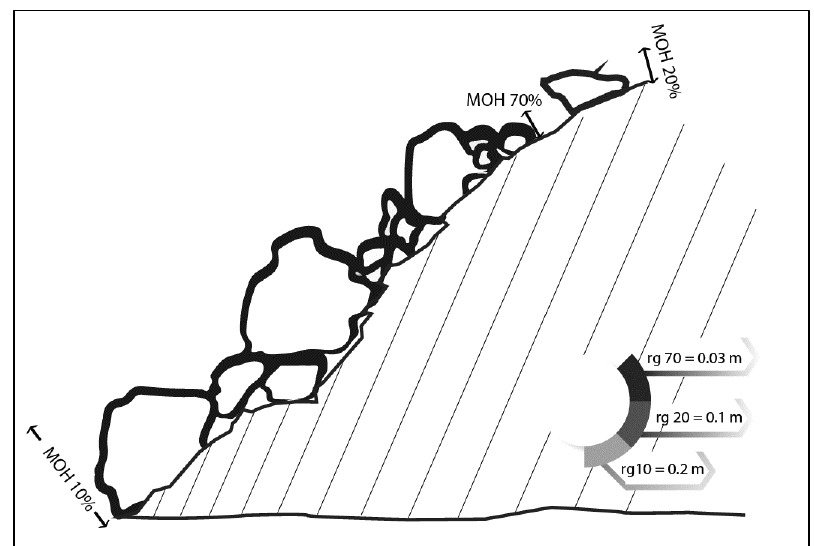
Figure 7. A sketch showing the obstacle heights (MOH) that account for 70%, 20%, and 10% of the slope’s surface, respectively. The MOH should be measured while looking downward, modified after (Rockyfor3D manual [45]).